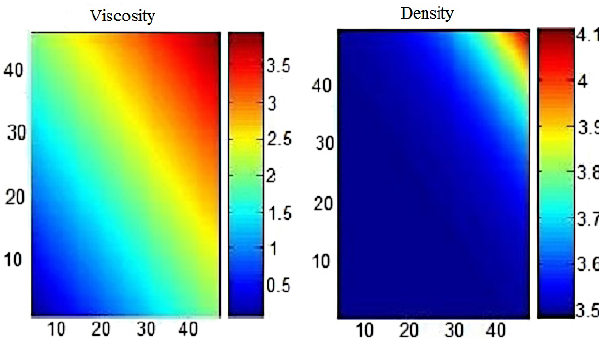
Figure 4. Distribution of viscosity η and density ρ ; 2-D case, ex- ponentially varying viscosity, high-viscosity contrast ( η 2 = η 3 = 100).